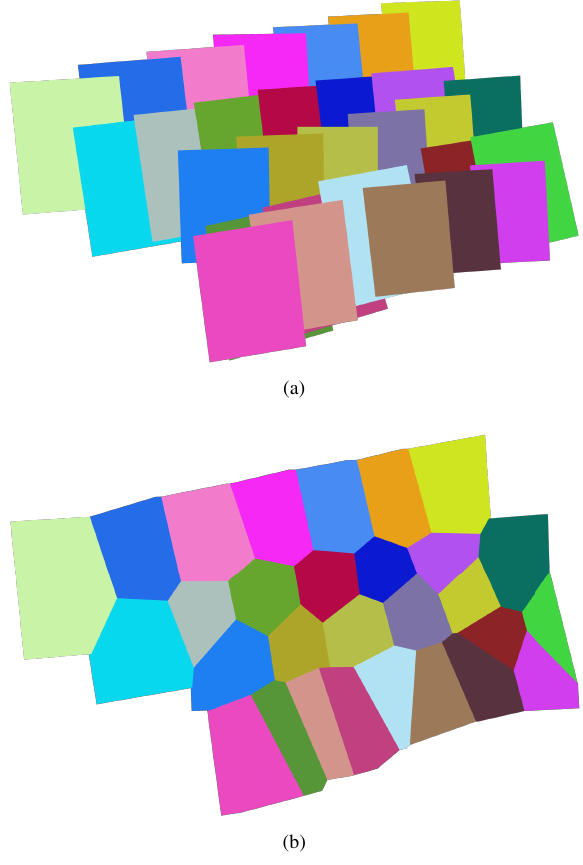
Figure 4. (a) Image frames projected onto the mosaic reference. (b) Voronoi tessellation.